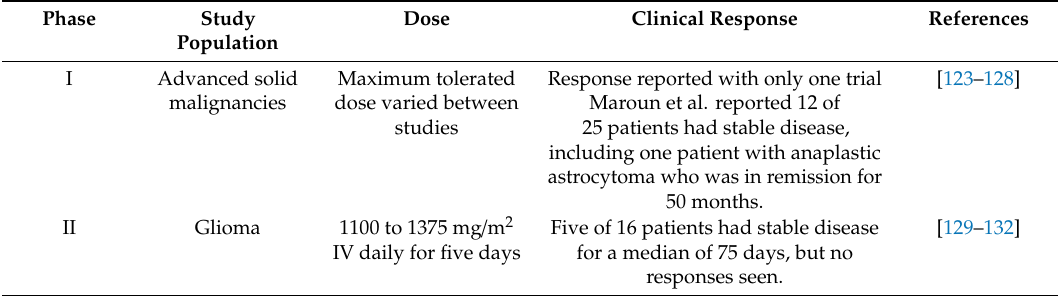
Table 3. Summary of clinical trials of Tiazofurin for solid malignancy.